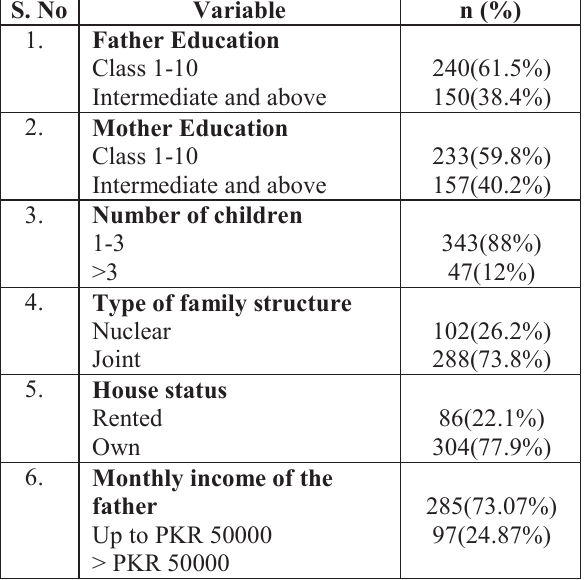
Table-1: Socio-demographic profile of the respondents